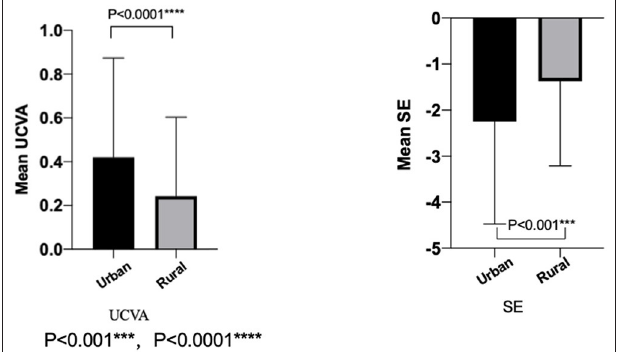
FIGURE 2 | The mean uncorrected visual acuity and spherical equivalent refraction in the urban and the rural of 2020.